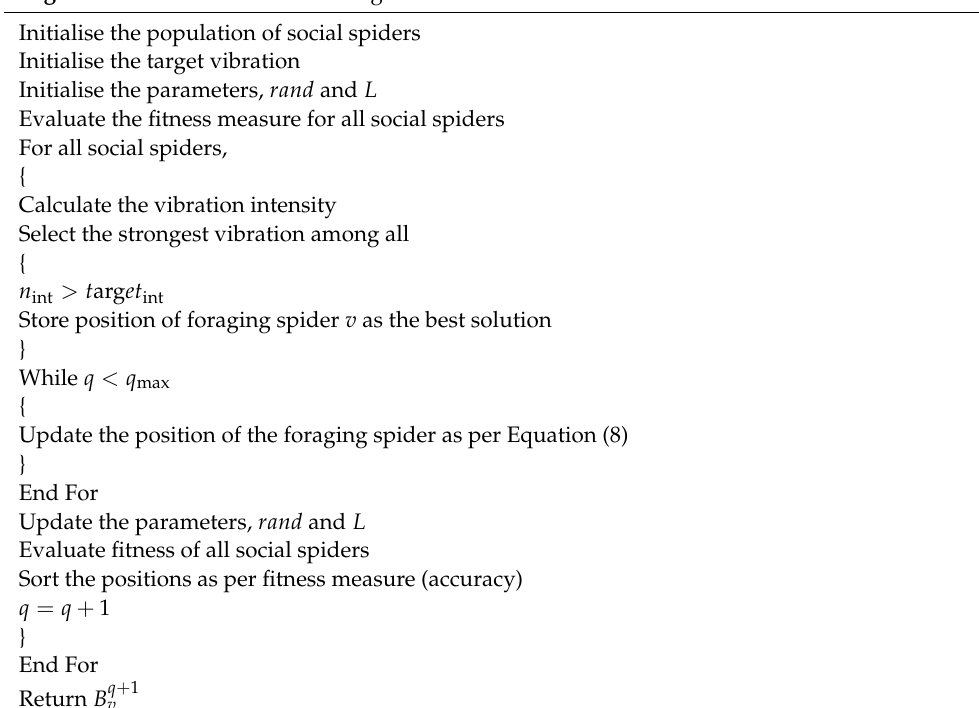
Algorithm 1. Pseudocode of SSO